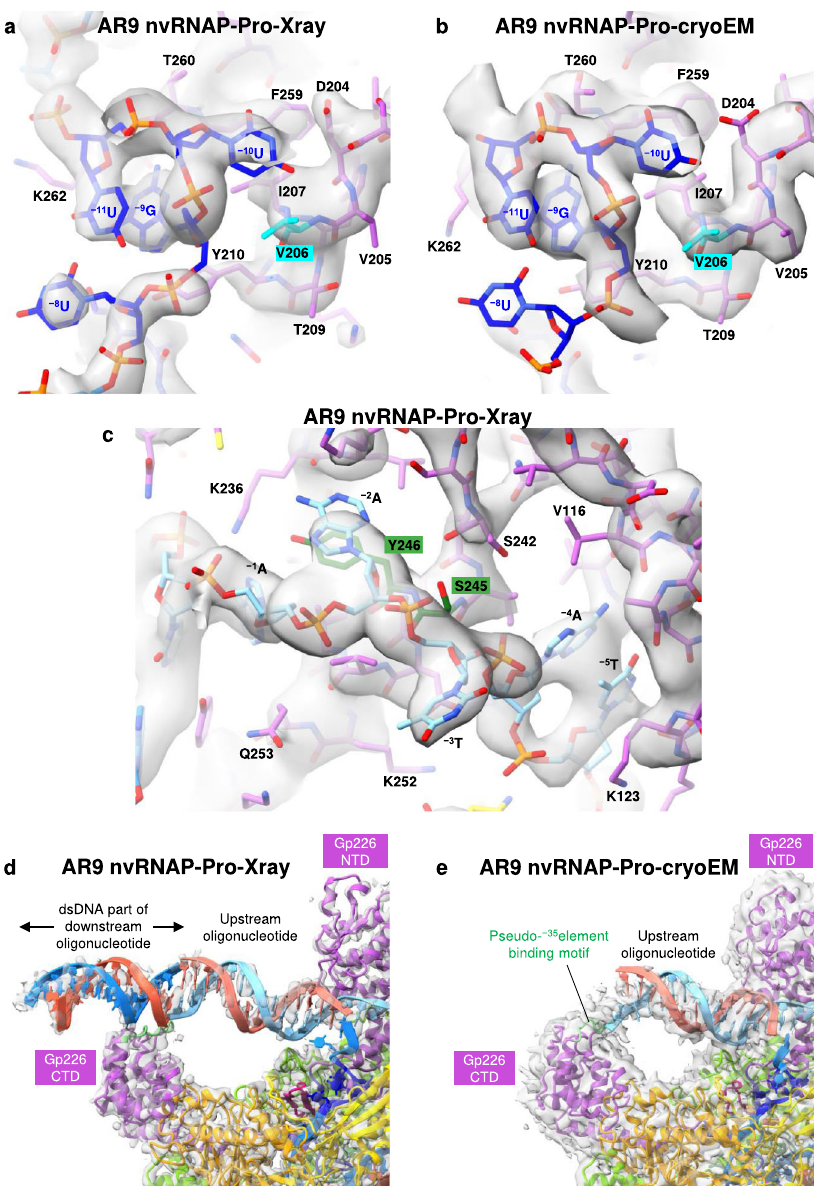
Fig. 7 Electron density of the AR9 nvRNAP-DNA interacting regions. a , b Composite omit X-ray electron density and cryo-EM map of the promoter binding pocket with re fi ned atomic models. The X-ray and cryo-EM maps are contoured at 1.5 and 5.0 std dev above the mean, respectively. The carbon atoms are colored as in Fig. 2a. V206, which is critical for U speci fi city, is colored cyan. c A fragment of composite omit X-ray electron density that is interpreted in terms of non-template strand nucleotides that are (fortuitously) partially complementary to the template strand promoter sequence. The X-ray map is contoured at 1.5 std dev above the mean. The carbon atoms are colored as in Fig. 2a. Residues Y246 and S245 that affect recognition of dsDNA template are colored forest green. d , e Composite omit X-ray electron density and cryo-EM map of gp226 CTD in the AR9 nvRNAP promoter complex. The cryo-EM and X-ray maps are contoured at 1.0 and 2.0 std dev above the mean, respectively. The ds segment of the downstream oligonucleotide belonging to a neighboring unit cell is shown in the X-ray map (see Supplementary Fig. 2c). The cryo-EM map of the upstream oligonucleotide is of insuf fi cient quality for model building and its atomic model has been copied from the AR9 nvRNAP-Pro-Xray structure for illustration purposes only. Proteins are colored as in Fig. 2a. The pseudo- − 35 element binding motif is colored light